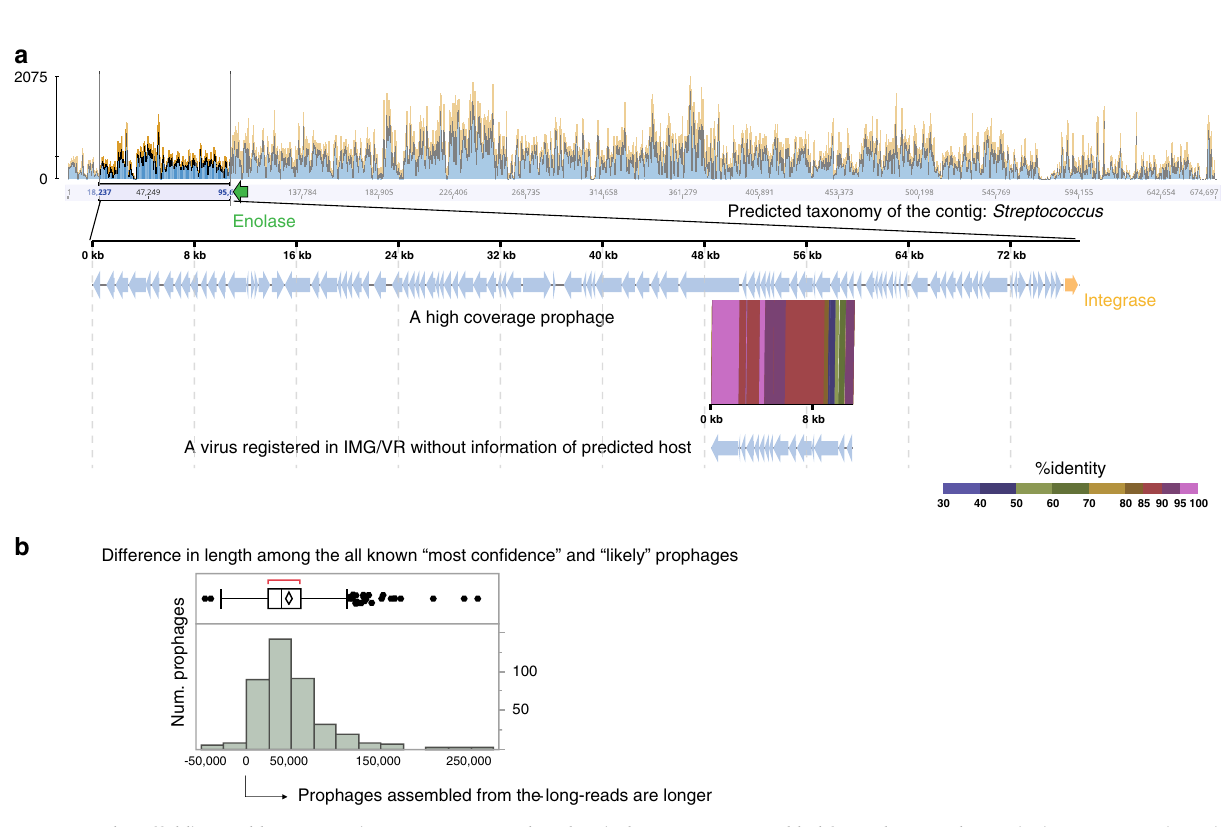
Fig. 2 Improved scaffolding and host genomic context compared to the viral sequences assembled from short-reads. a A high coverage oral prophage showing the improvement. Top: coverage plot based on mapping short-reads against it. The prophage region is indicated as a rectangle in the coverage plot spanning the entire contig. Genomic alignment of a high coverage prophage and its viral sequence registered in IMG/VR v2.0 database is shown; the percentage of identity was calculated based on tBLASTx. b Distribution of the differences in length between each of the “ most con fi dence ” and “ likely ” prophages and their corresponding viral sequence in the IMG/VR v2.0 database. In the box plot, left and right of the box indicate 25th and 75th percentile, horizontal line indicates median, the middle of the diamond indicates average, the right outliers are above 75th percentile + 1.5× interquartile range, and the red indicates the shortest range in which half of the data distributes. n = 393 pairs of prophages and their corresponding viral sequence in the IMG/VR v2.0